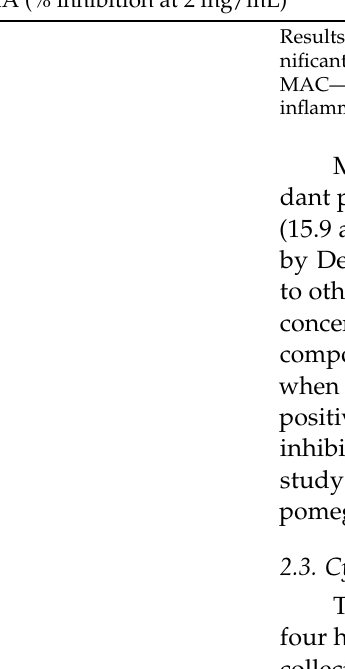
Table 3. Antioxidant properties of P. granatum leaf hydroethanolic extracts. Antioxidant Activity MAE UAE MAC TBARS (IC 50 values, µ g/mL) >2000 >2000